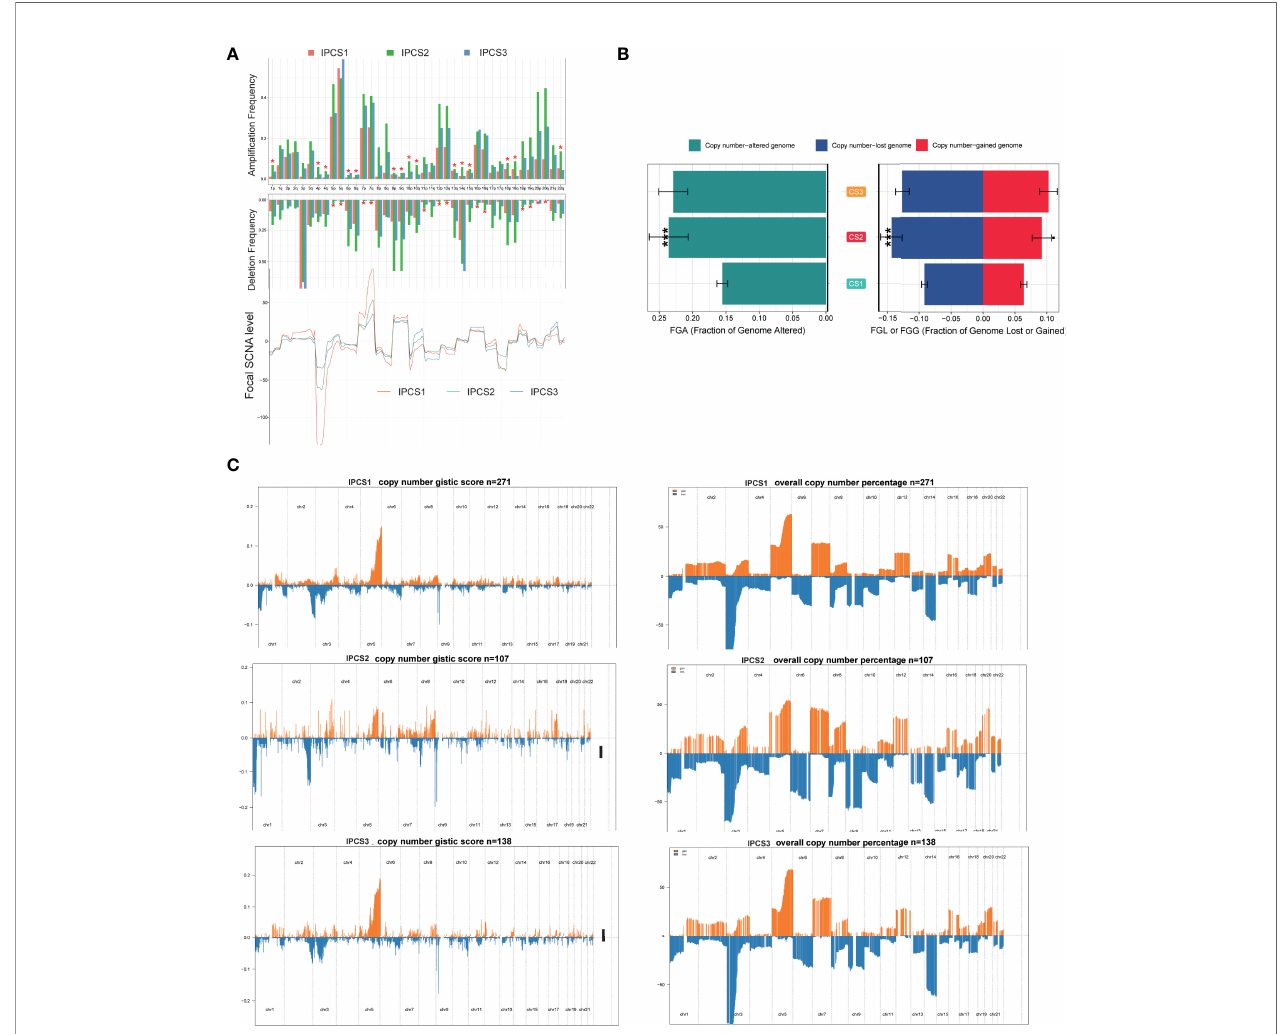
FIGURE 7 | Landscapes of copy number variations among the three subtypes. (A) The ampli fi cation or deletion frequency in chromosomes among IPCS1, IPCS2 and IPCS3. (B) Barplot of genomic fractions altered among the three subtypes. (C) The GISTIC score and percentage of copy number pro fi les in